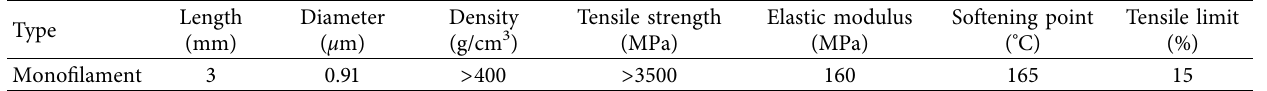
Table 3: Properties indexes of PP fiber.